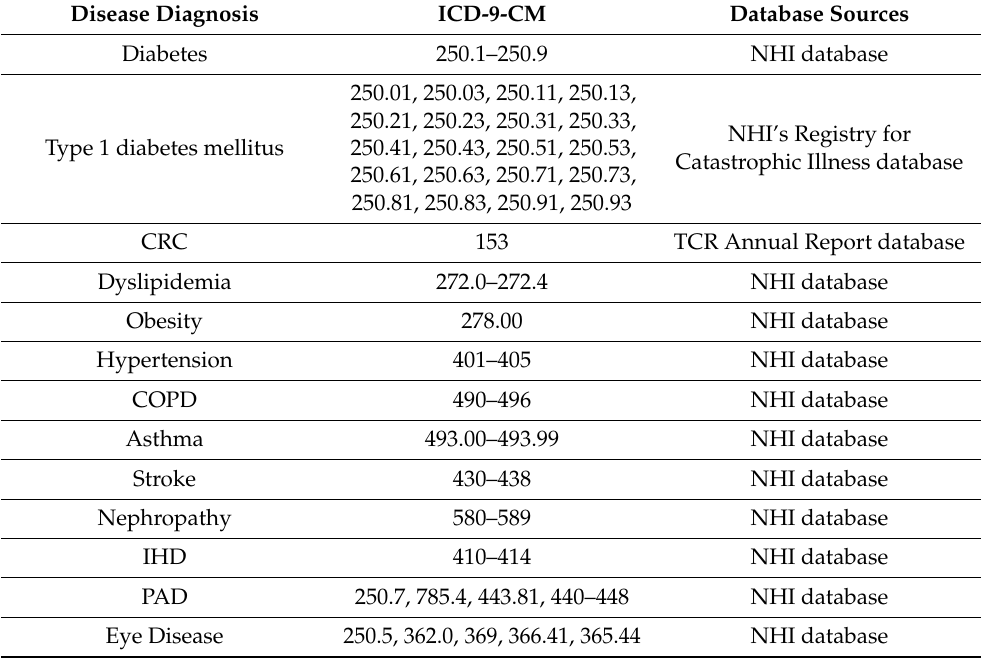
Table A1. International Classification of Diseases, Ninth Revision, Clinical Modification (ICD-9-CM) codes used for disease diagnosis in our study.